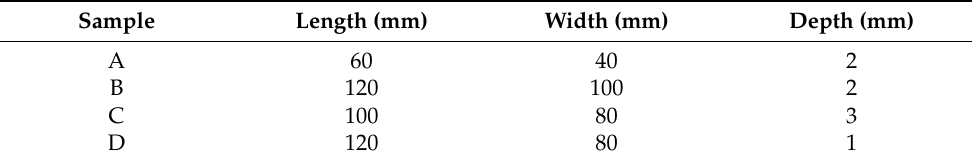
Table 2. Dimensions of dent samples.